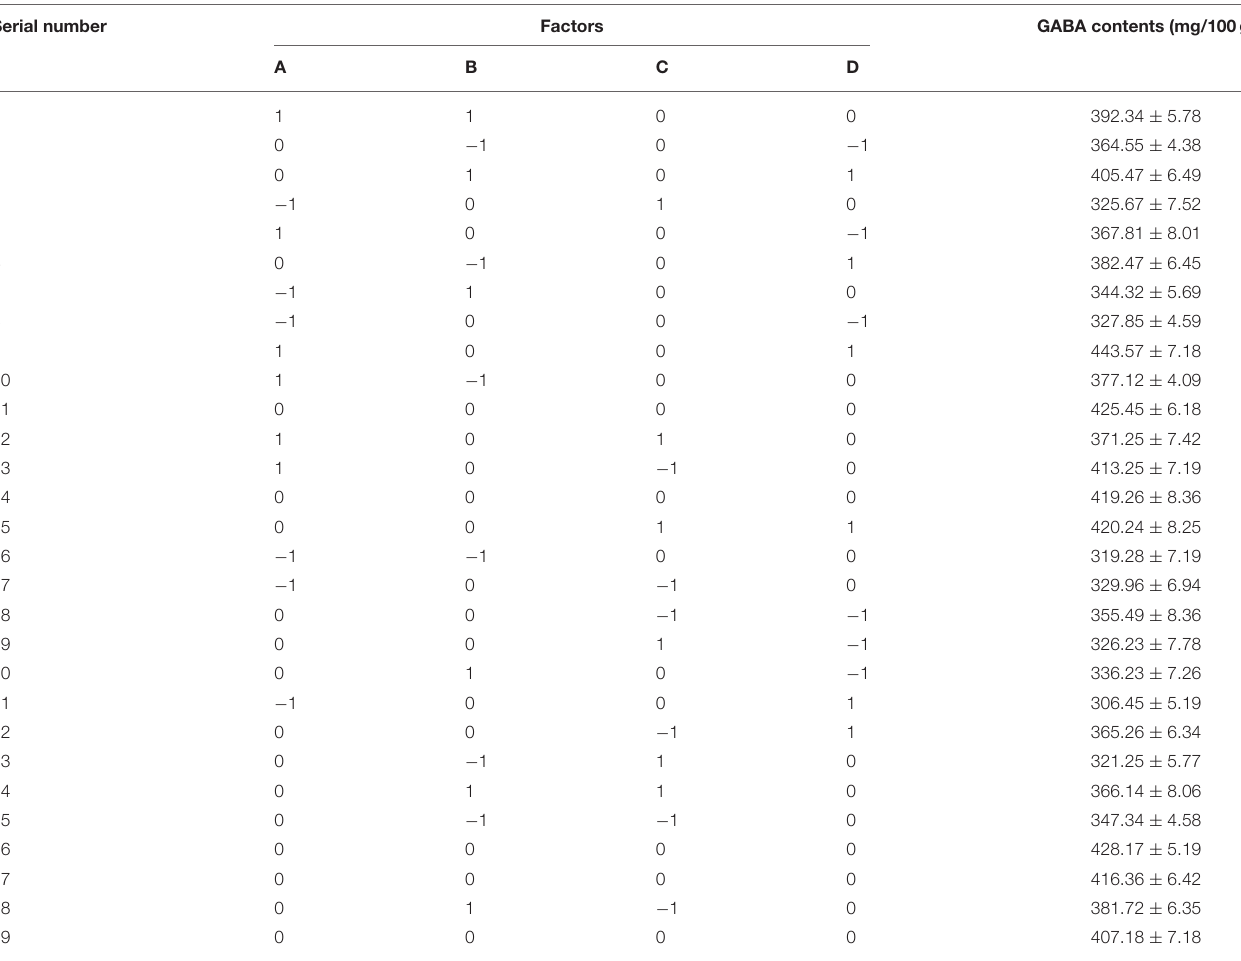
TABLE 1 | Response surface design and results. Serial